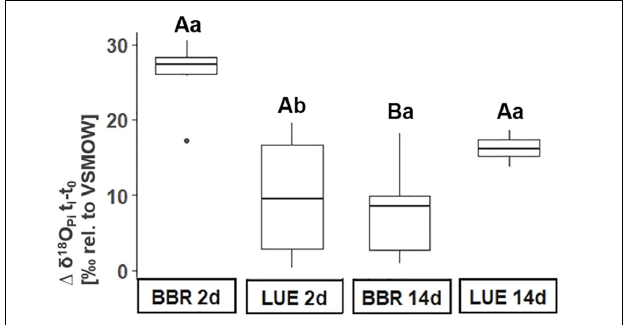
18 O-enriched water (ti) in the control plots. ti refers to the two time points after label application (2 d and 14 d = 2 days and 14 days, respectively). Lowercase letters indicate significant differences between sites, whereas uppercase letters refer to significant differences between sampling dates. BBR = Bad Brückenau; LUE =